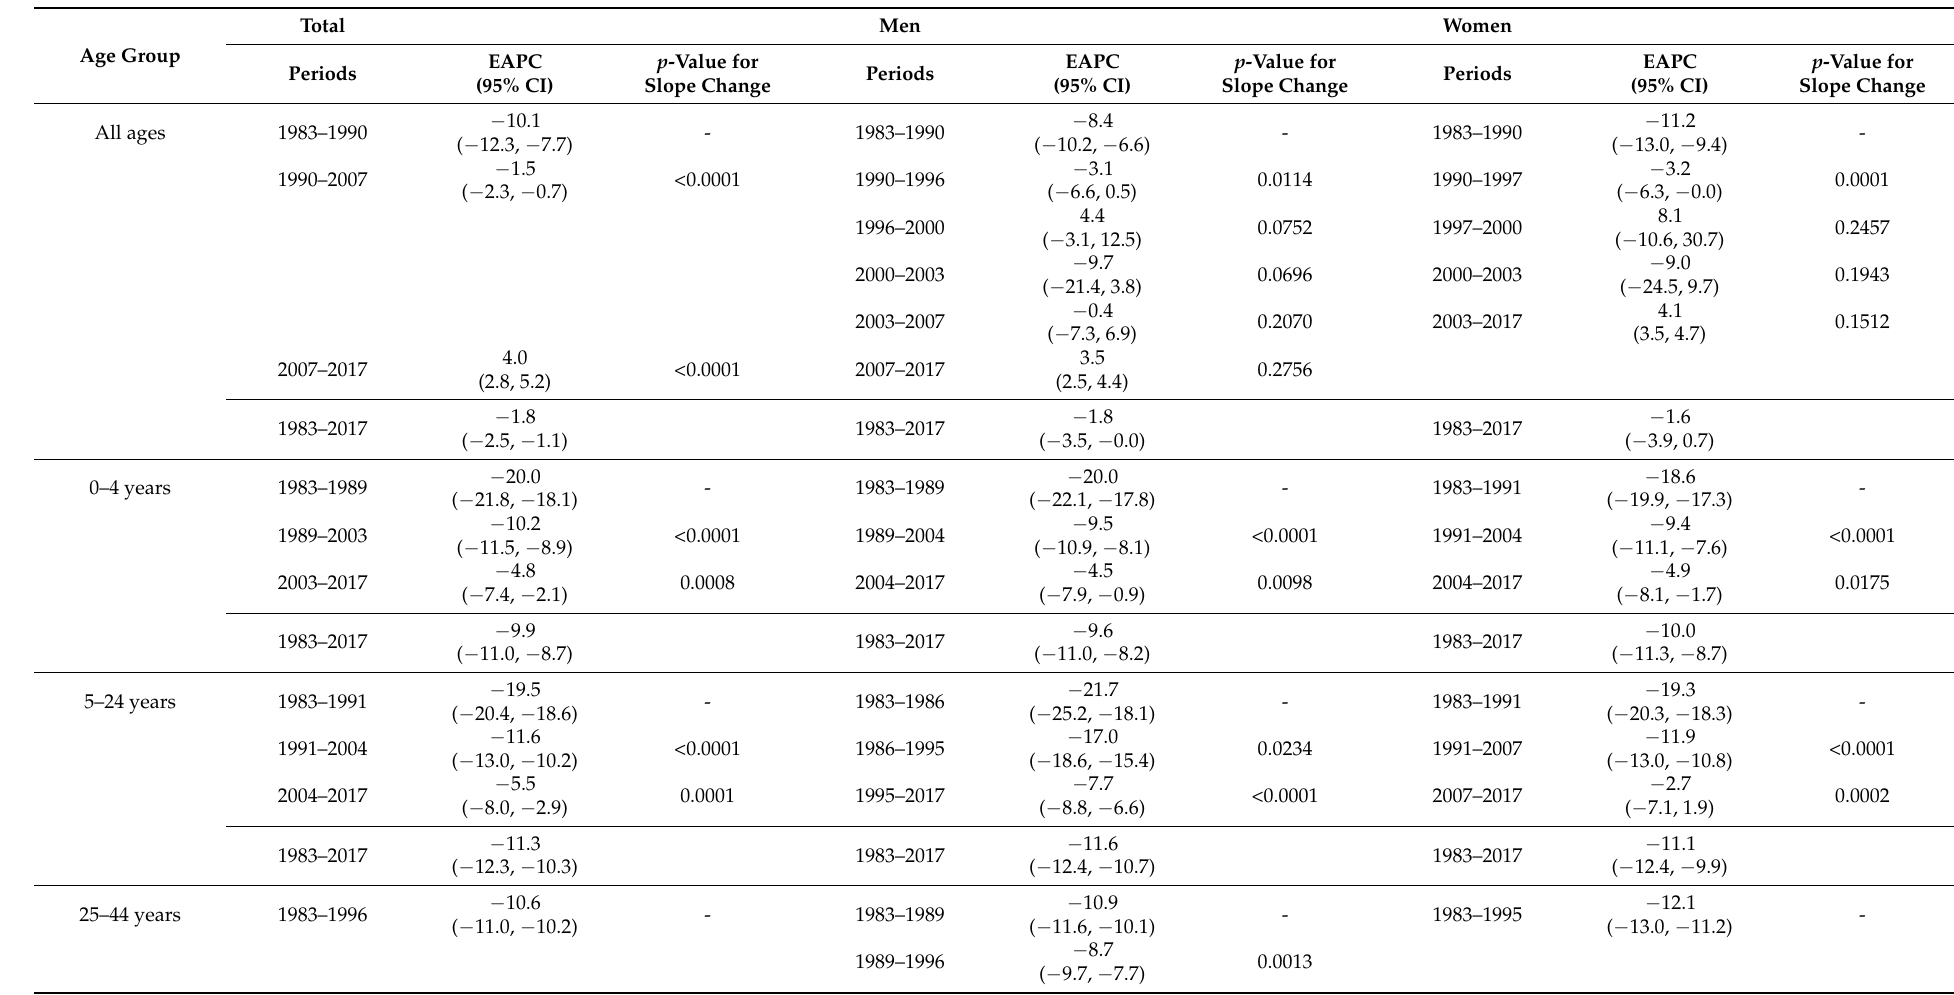
Table 1. Changes in age-standardized mortality rates from infectious diseases by sex and age group in South Korea from 1983 to